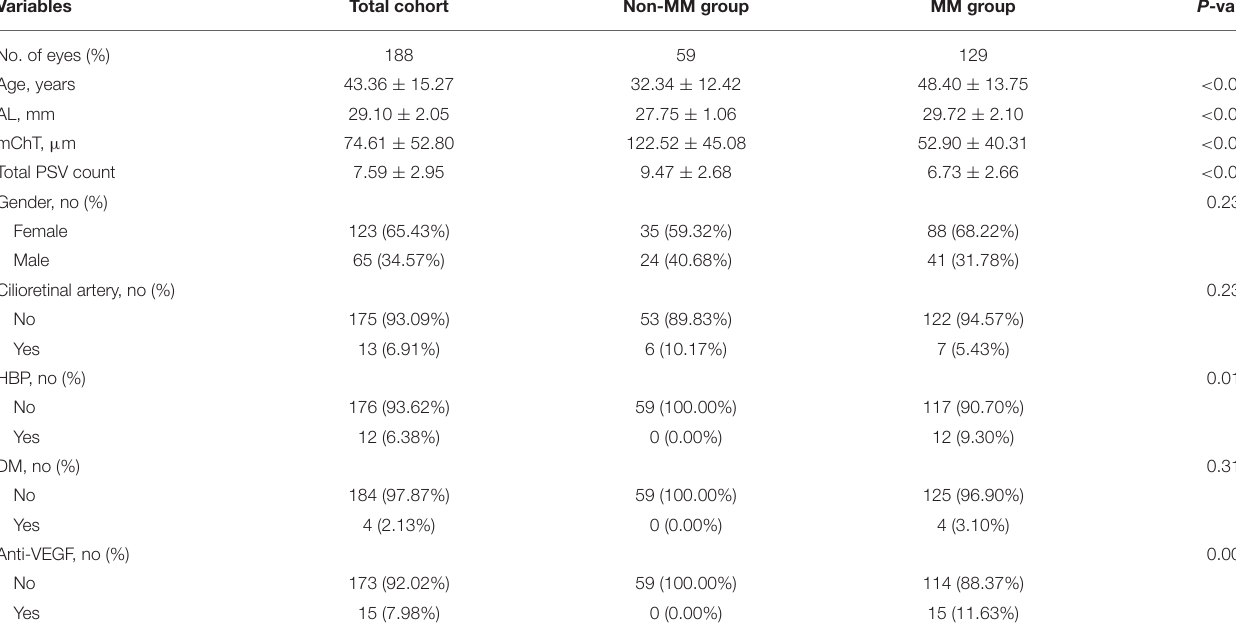
TABLE 1 | General characteristics of participants with and without myopic